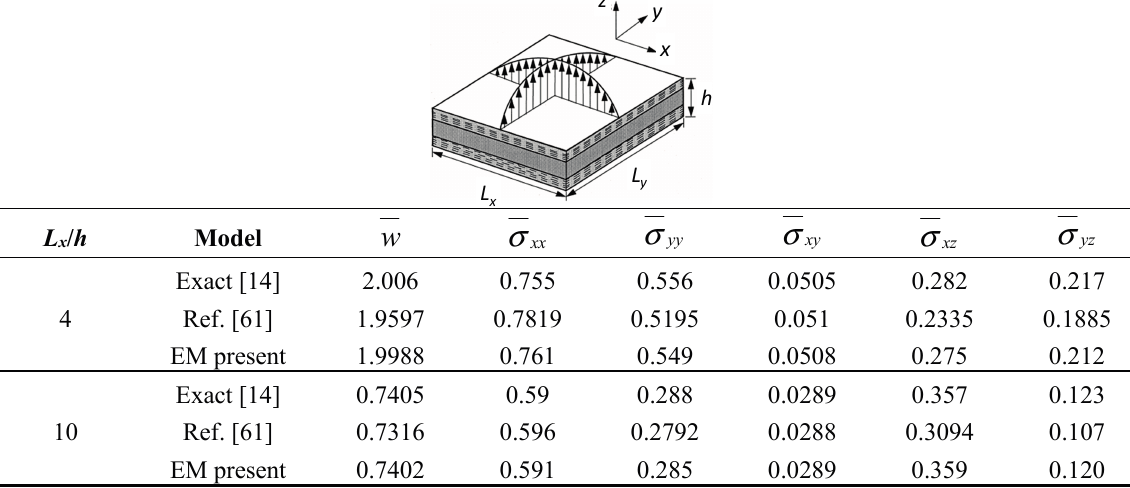
Table 1. Non-dimensional deflection and stresses of simply supported laminated <0°/90°/0°> plate under bi-sinusoidal